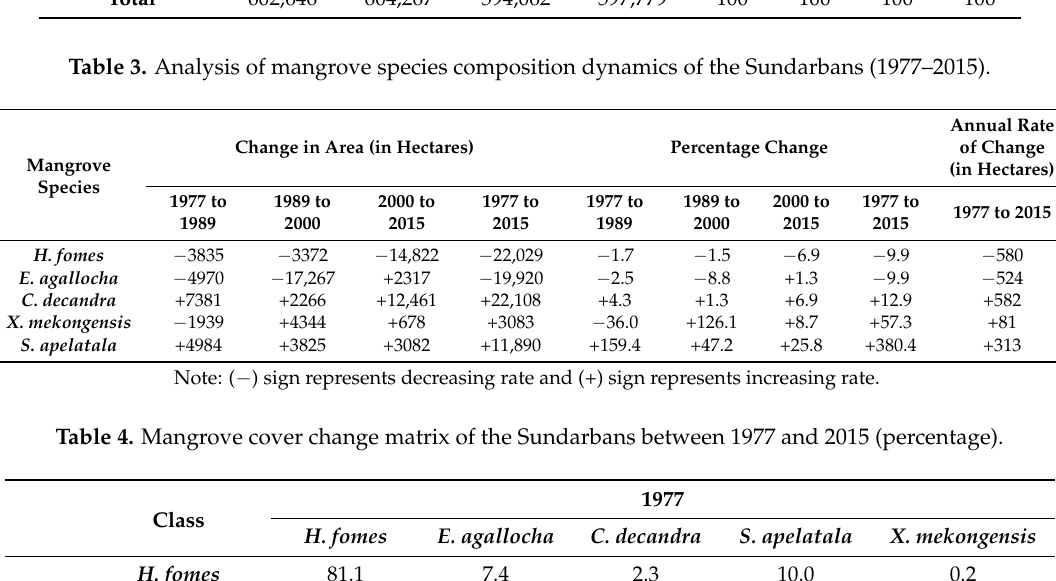
Table 3. Analysis of mangrove species composition dynamics of the Sundarbans (1977–2015).